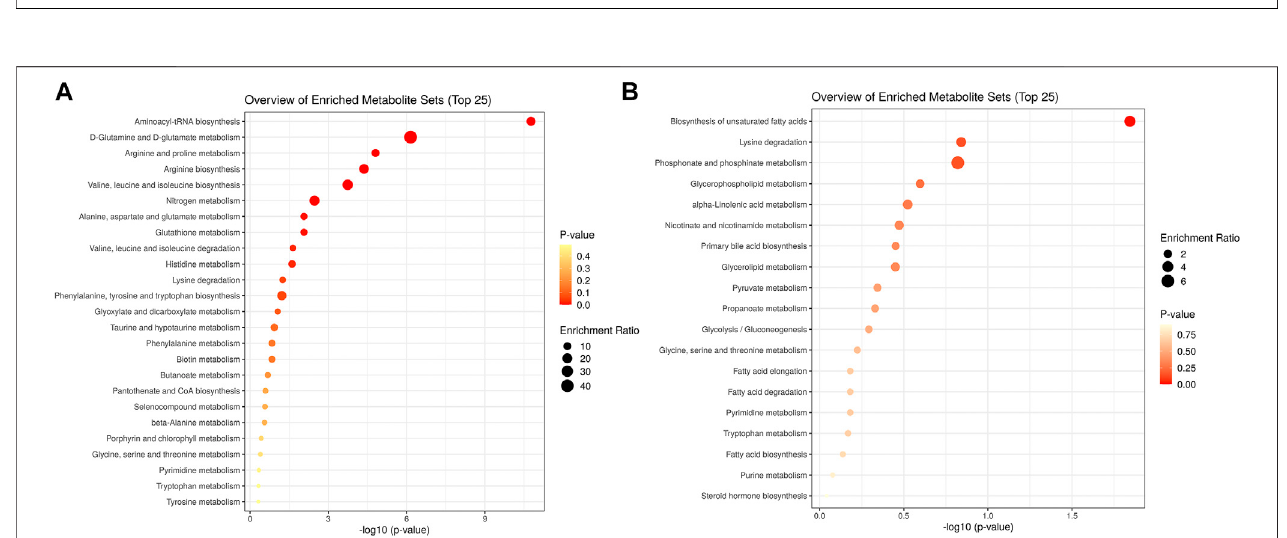
FIGURE 5 | KEGG pathway enrichment analyses of the differential metabolites in hypopituitarism vs. healthy controls (A) . enrichment of differential metabolites of amino acids; (B) . enrichment of differential metabolites of non-amino acid metabolites.